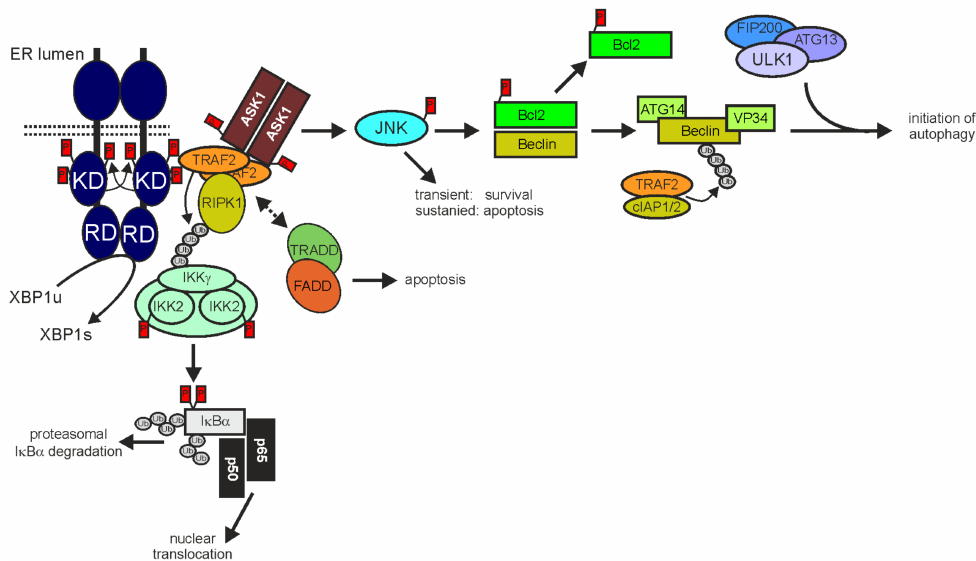
Figure 4. TRAF2 in IER1 signaling. After ER stress-induced dimerization IRE α triggers production of the transcription factor XBP1 by its endonuclease activity engages splicing and recruits TRAF2 to trigger ASK1/JNK signaling but also, by still poorly studied mechanisms, classical NF κ B signaling and apoptosis. The IRE1 α /TRAF2/ASK/JNK axis is also connected with autophagy by the JNK- mediated phosphorylation of the Beclin inhibitory Bcl-2 protein. Interestingly, TRAF2 in concert with cIAP1/2 can further contribute to autophagy by K63-ubiquitination of Beclin. For more details refer to main